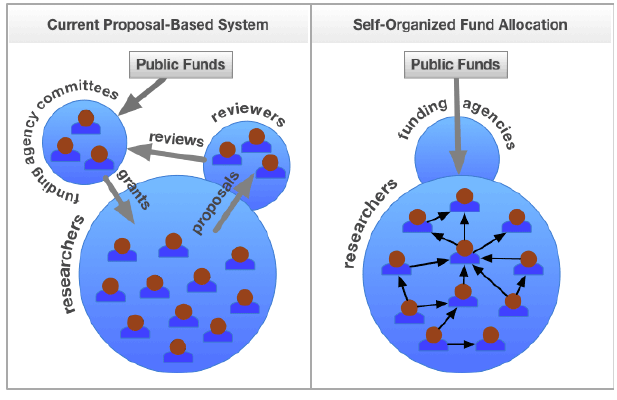
Fig. 1 . Schematic comparison of the current fund allocation model compared with the self-organized fund allocation